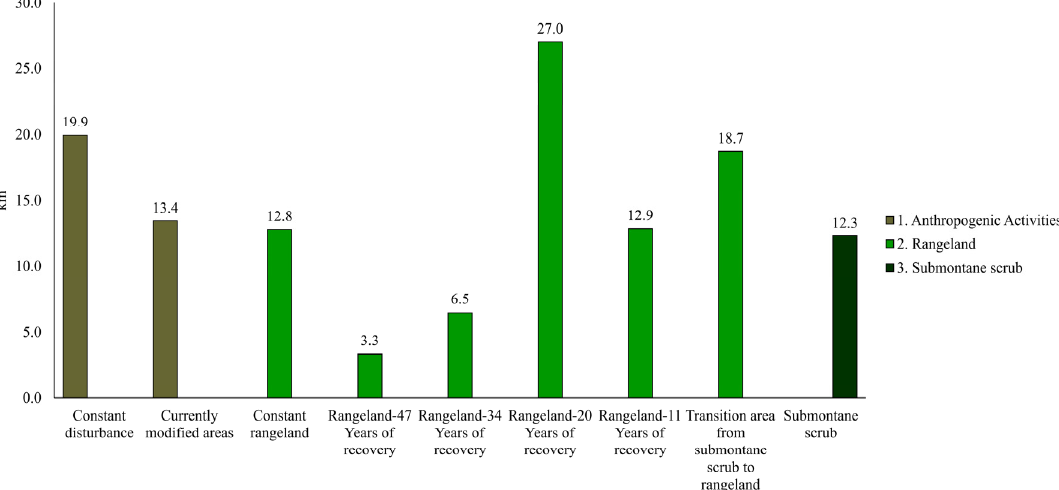
Figure 5. Represented Area (km 2 ) for each category of land use coverage during the study period, San Rafael, Tula, Tamaulipas, Mexico.